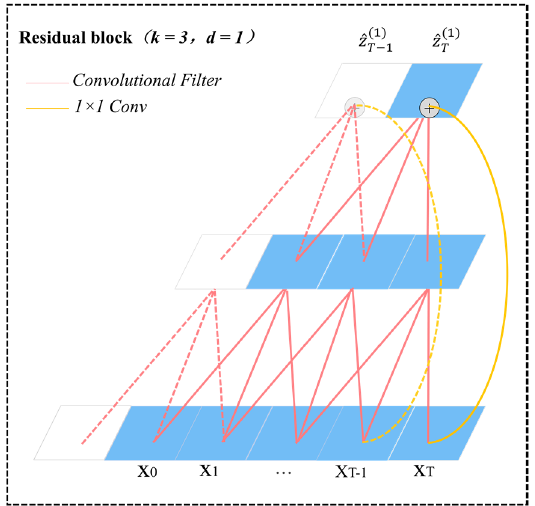
Figure 4. An example of residual connection in a TCN. An additional 1 × 1 convolution is added to ensure that the elements summing up receive tensors of the same shape. The red lines are filters in the residual function and the yellow lines are identity mappings.